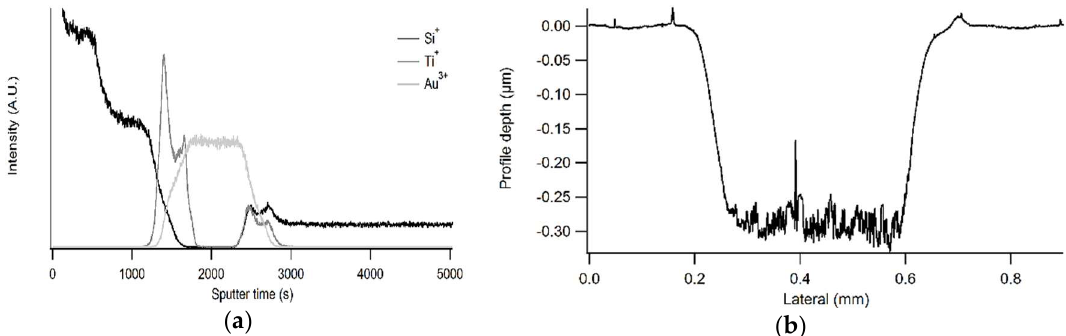
Figure 8. Complete profile of Si model sample b obtained with SIMS ( a ). Profilometry analysis ( b ) was conducted on a fresh zone and sputtering was stopped when the Ti signal reached half of the maximal intensity.